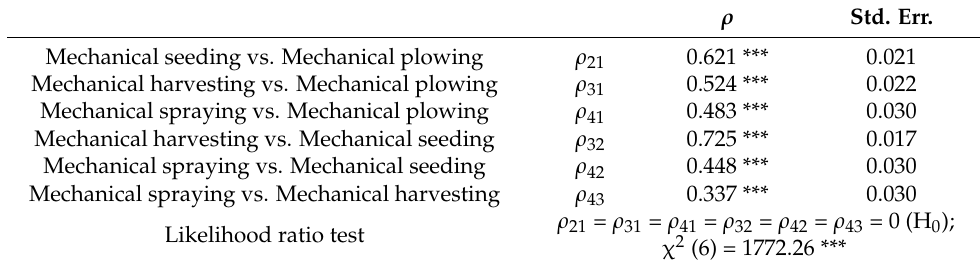
Table 4. Correlation coefficients of machinery technology adoption equations.